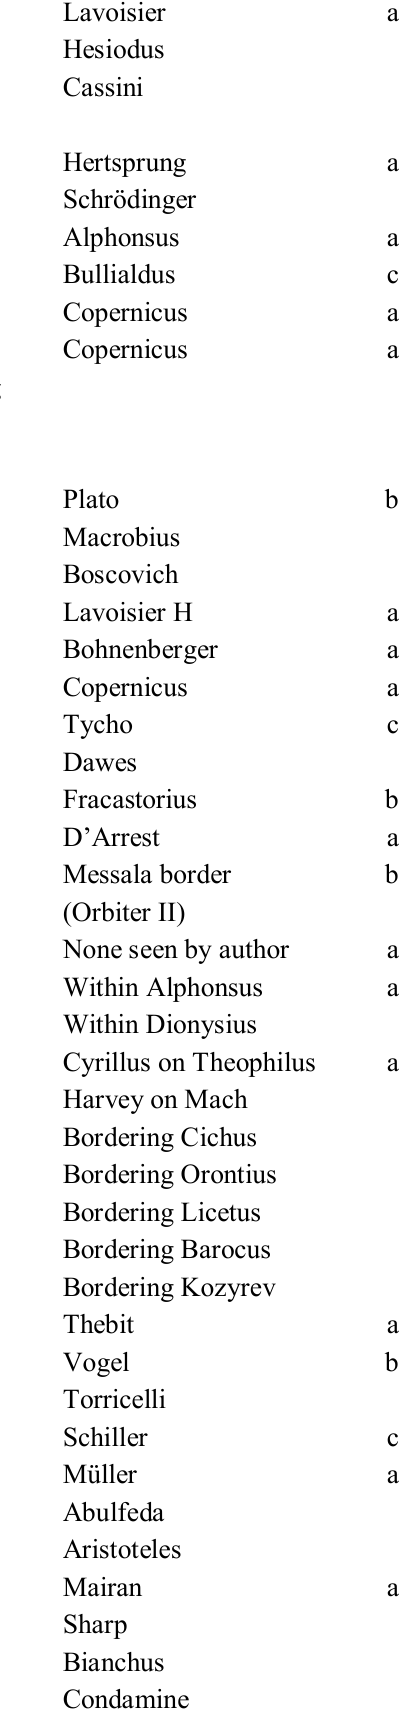
refers to the change of dip angle where dip is the angle of tilt of layering as a function of view angle. For example, a steeply dipping lava flow might appear nearly horizontal depending on the direction of